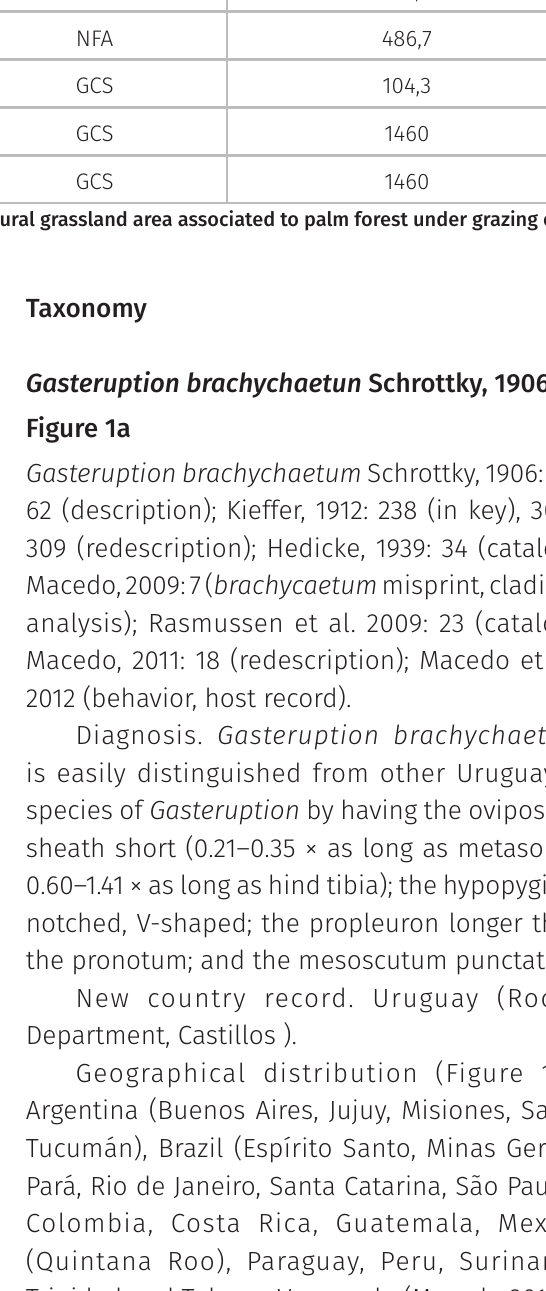
Table I. Species of Gasteruption Latreille, 1796 obtained near the municipality of Castillos, Rocha Department, Uruguay, between December 2014 and December 2016: number of specimens per locality sampled, and sample effort in trap-days. Species of Gasteruption n Locality sampled Sampling effort (in trap-days)